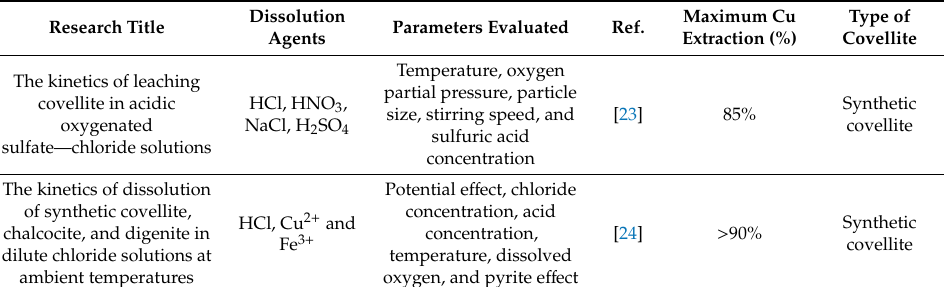
Table 1. Comparison with other investigations under similar conditions.